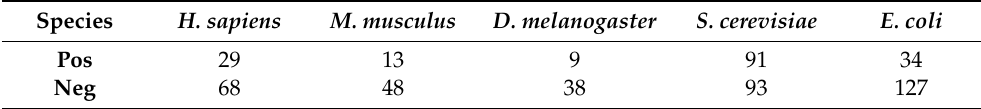
Table 5. The distribution of D in five